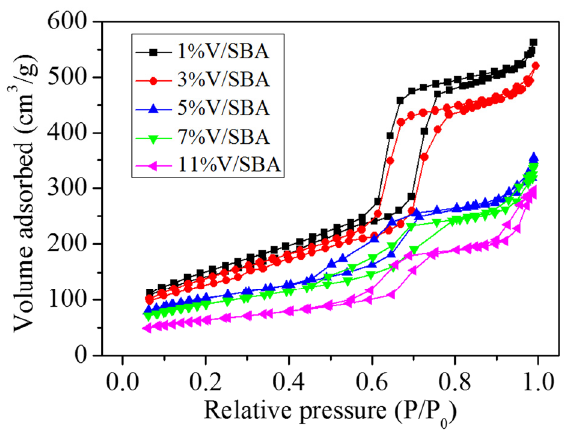
Figure 2. Nitrogen sorption isotherms of vanadia catalysts supported on SBA ‐ 15 (V/SBA) catalysts with different vanadium content. Table 1. Physico ‐ chemical properties of SBA ‐ 15 ‐ supported vanadia catalysts.